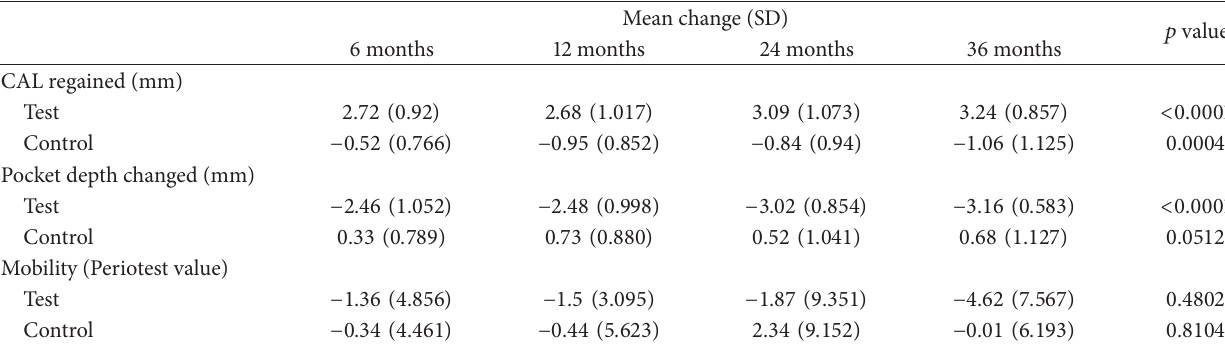
Table 1: Clinical